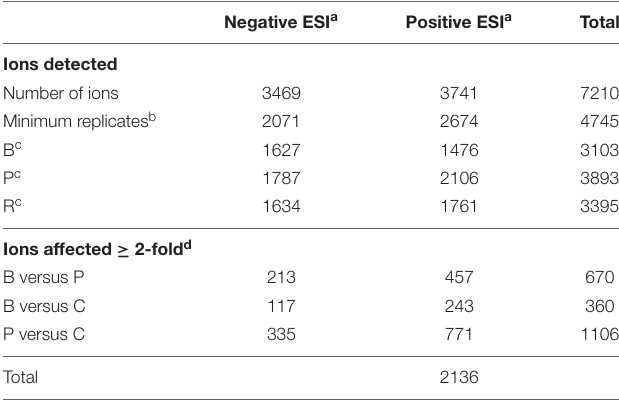
a ESI, electrospray ionization. b Ions detected in a minimum of n-1 samples from at least one of the three sample groups. c B, Buiuçu; P, Puruzinho; R, Rio de Janeiro. d p value < 0.05, as determined by unpaired t